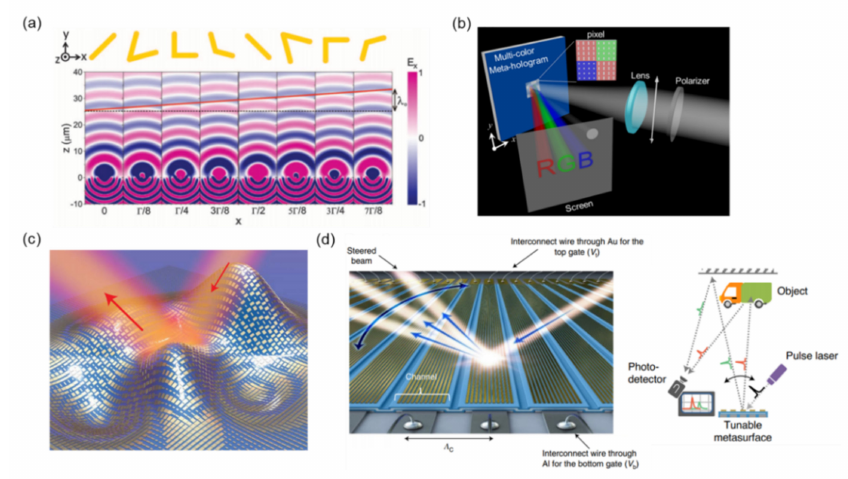
Figure 2. ( a ) Finite-difference time-domain simulations of the scattered electric field with V-antenna arrays [101]. ( b ) Illustration of the multicolor metahologram [102]. ( c ) Schematic of a metasurface skin cloak [103]. ( d ) Illustration of 3D LiDAR composed of a metasurface and electrically tunable channels